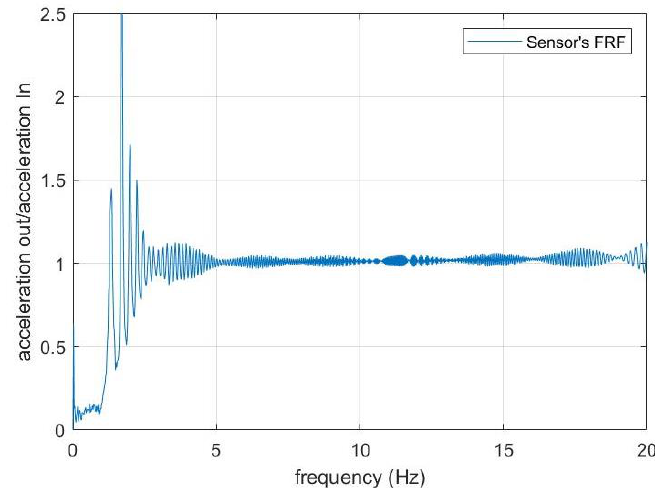
Figure 9. Frequency response function of the sensor package for 1–20 Hz